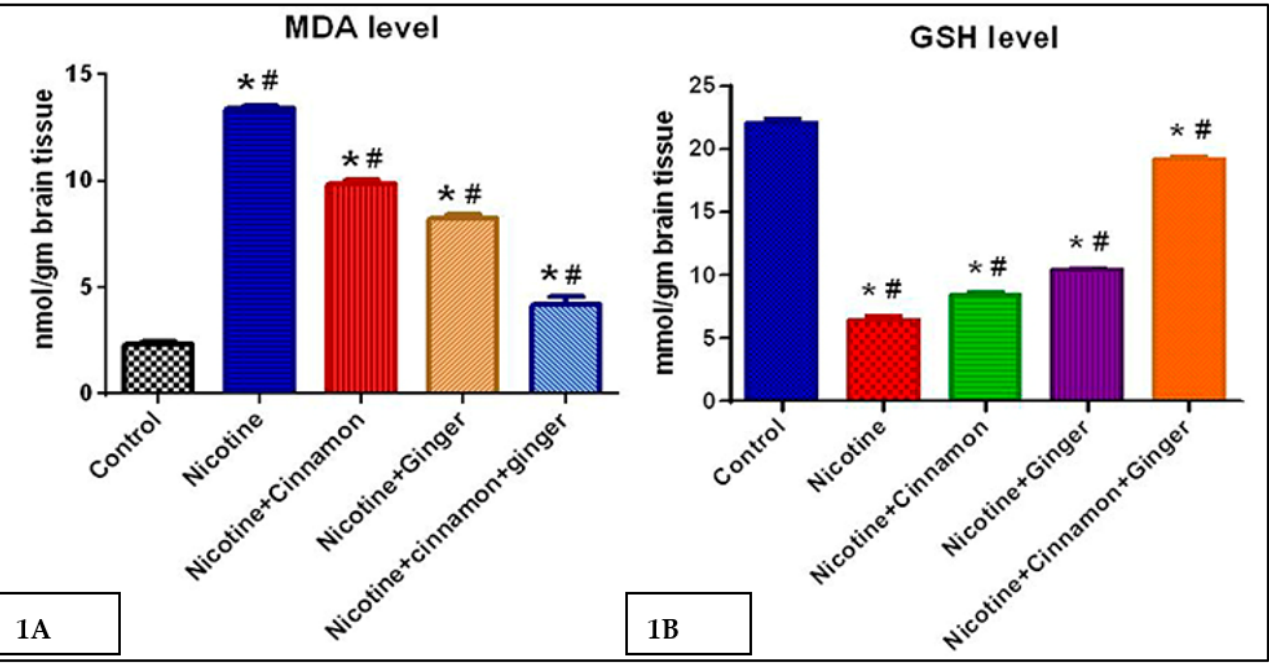
Table 1. MDA level in nmol/gm in the brain tissue of the different groups. Table 2. GSH level in mmol/gm in the brain tissue of the different groups .